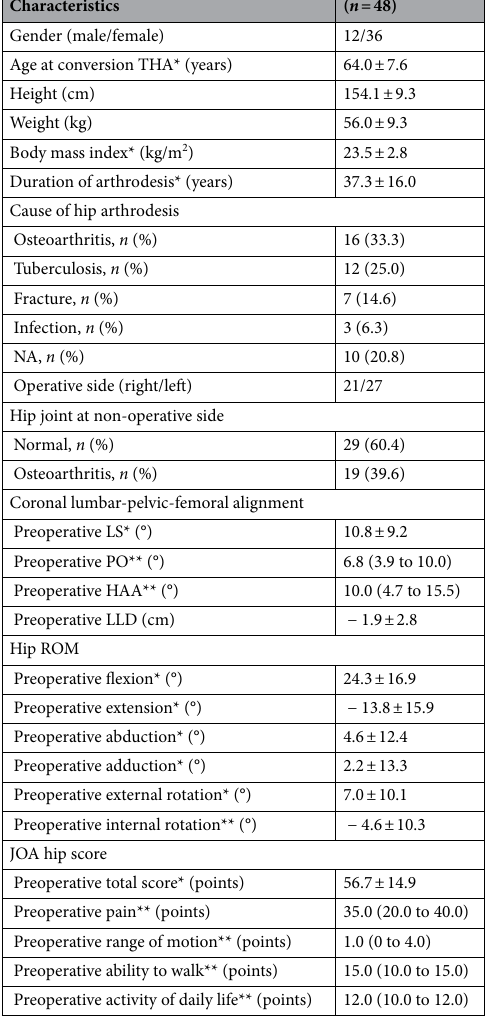
Table 1. Patient characteristics. THA , total hip arthroplasty. ROM , range of motion. NA , not available. JOA , Japanese Orthopaedic Association. *Values are the mean ± standard deviation. **Values are the median (interquartile